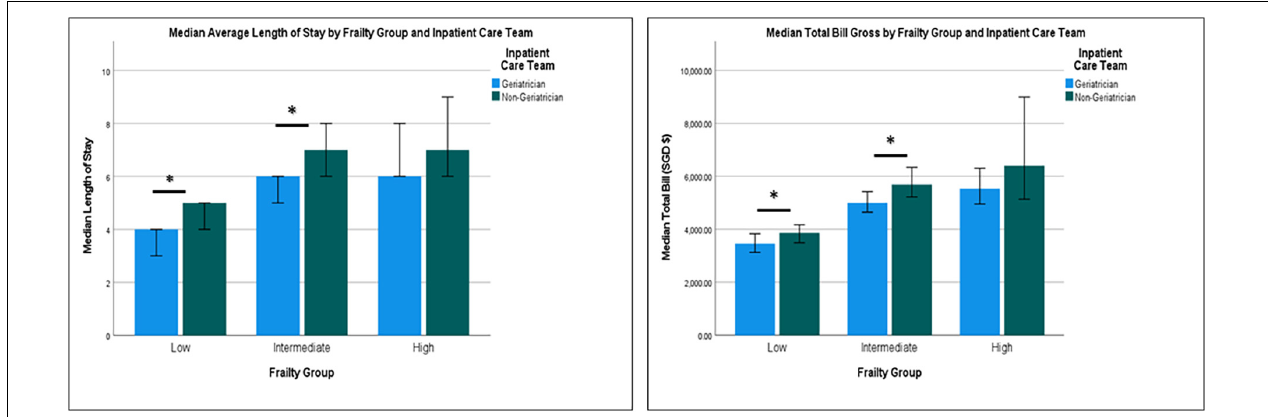
FIGURE 3 | Median length of stay and total bill by frailty group and inpatient care team.